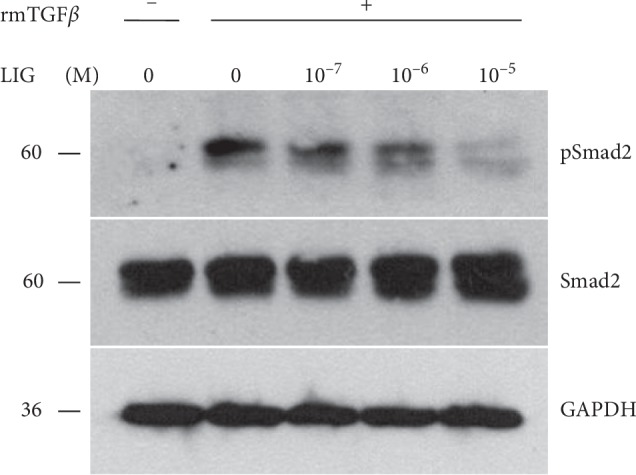
The dose-dependent effect of LIG on TGFβ activation in mouse IVD ex vivo. Western blot analysis of pSmad2 and total Smad2 levels in the IVD, pretreated with 2 ng/mL of rmTGFβ1 combined with 10−5, 10−6, and 10−7 M LIG.